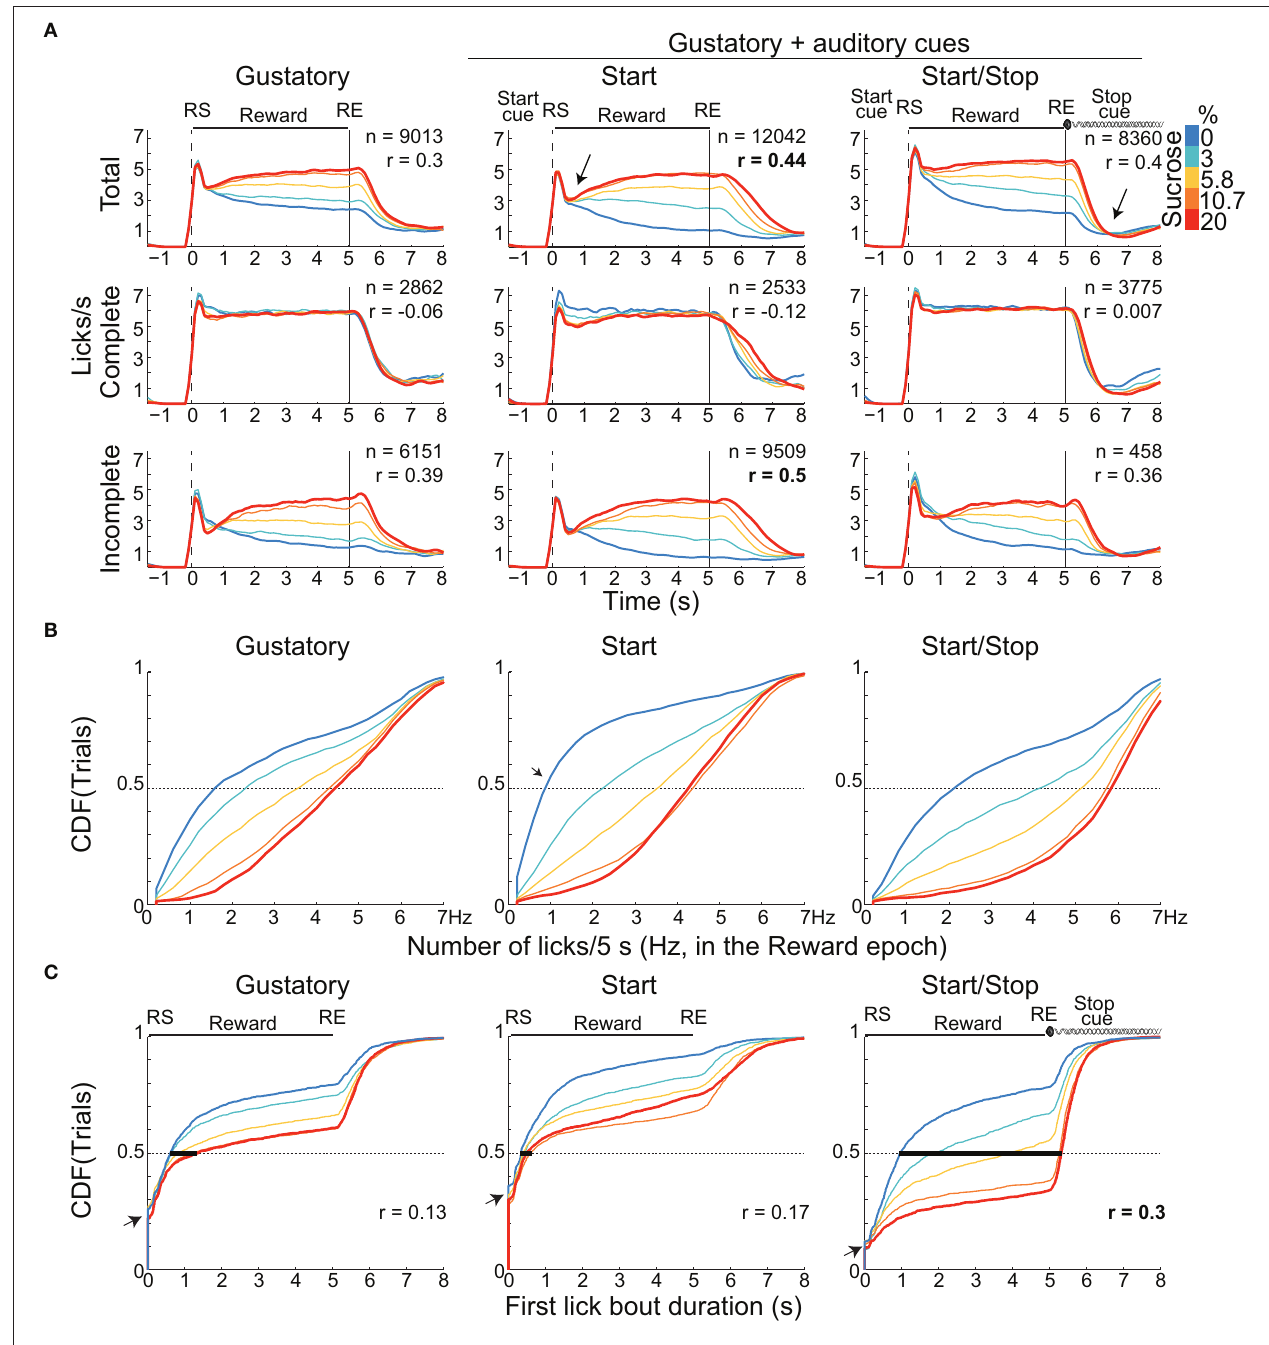
FIGURE 2 | Animals exhibit distinct palatability (behavioral) responses that depend on the presence of auditory cue(s). (A) The lick rates (licks/s) for the three brief-access tests aligned to the RS (vertical dashed line) as a function of sucrose concentration. The licking responses are shown for the “Total” trials (upper), for Complete (middle) and Incomplete trials (bottom panels). The n’s are the number of trials pooling across animals and sessions. Only the Total and Incomplete trials significantly discriminate among the sucrose concentrations. The arrow in the PSTHs of the Start test highlights the abrupt decrease in lick rate for all tastants after which the lick rate tracks the sucrose concentration. The arrow just after RE in the Start/Stop test indicates that animals rapidly stopped licking. Also shown is the Pearson’s correlation (r’s) between the lick rate in the Reward epoch and the sucrose concentrations. (B) Cumulative distribution functions (CDFs) for the lick rate (total number of licks during the entire 5s Reward epoch). (C) The CDFs of the first bout duration over the range of RS for the three tests. The bold horizontal lines at 0.5 on the Y-axis indicate the median bout duration for each sucrose concentration. Note that the first lick bout duration was largest in the Start/Stop test and it was the most positively correlated with sucrose concentrations (see r’s). The small arrows in the CDF’s indicate the fraction of trials where animals made their first lick bout with a one-lick (bout durations equal